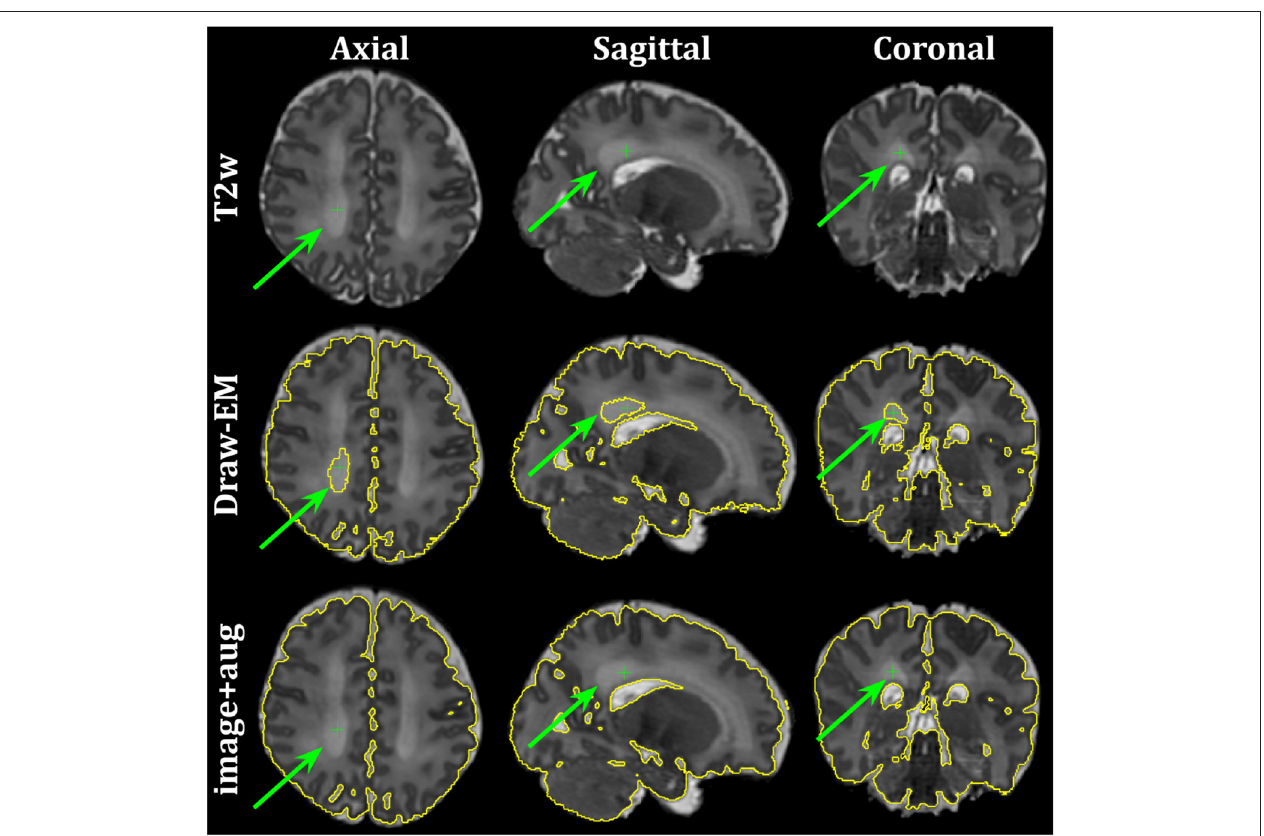
FIGURE 10 | Example of a neonate from the ePrime dataset with GA = 32.86 w and PMA = 39.86 w where the Draw-EM algorithm performed worse than our proposed image with augmentation model. The green arrow points at a region which was segmented as CSF by Draw-EM, but then corrected by our